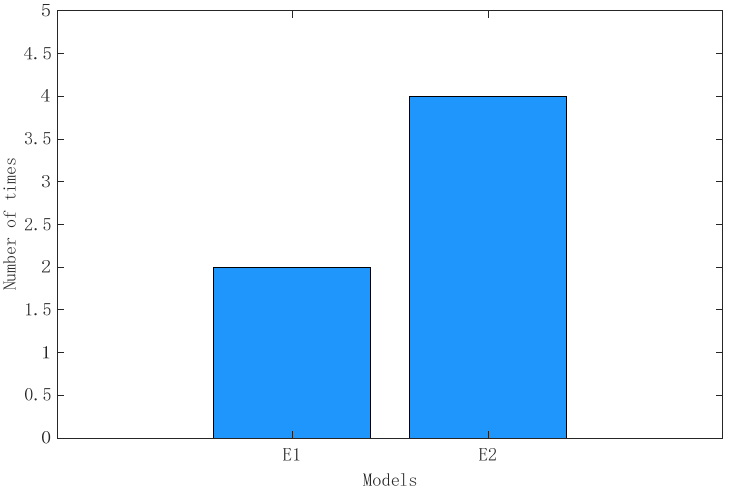
Figure 13. The number of times each model was controlled at the original node in the workflow.